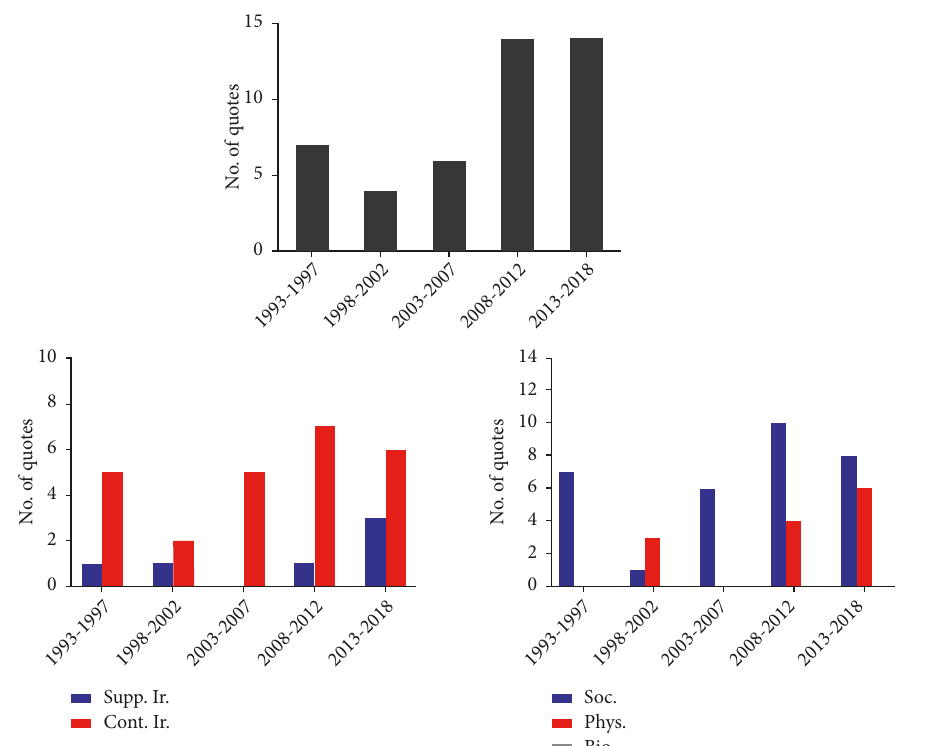
Figure 4: Visualising temporalanalyses on quotes thatincludetheterm irrationality.The columncharton thetop representsthetotal number of quotes and the ones in the bottom splits the frequency based on whether the quotes support or contradict the theory (chart on the left) and based on the study discipline (chart on the right). To account for the fact that the last time interval includes 6 years as opposed to the rest of the time intervals that include 5 years, the numbers associated with the last interval have been scaled down by a factor of 5/6. The very few studies covered by this review and published prior to 1993 or in 2019 we accommodated in the first and last intervals